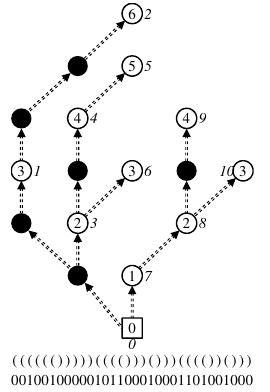
Figure 6. Zero-edge tree and a dummy node vector obtained from the ZDD in Figure 3.